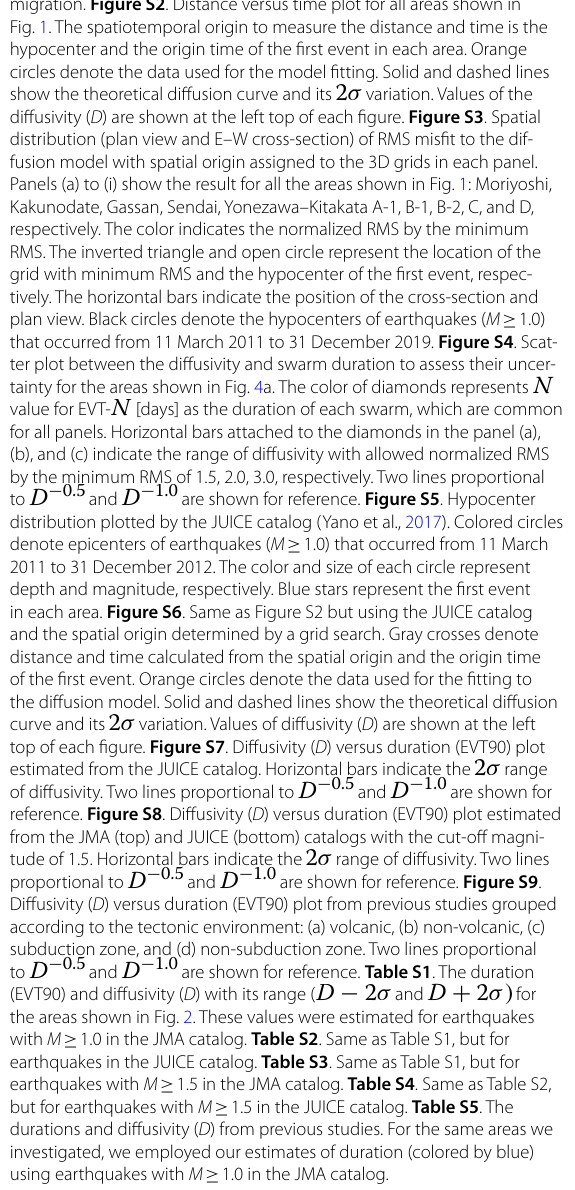
indicate no D value for Yonezawa–Kitakata A-2 because of no apparent migration. Figure S2 . Distance versus time plot for all areas shown in Fig. 1. The spatiotemporal origin to measure the distance and time is the hypocenter and the origin time of the first event in each area. Orange circles denote the data used for the model fitting. Solid and dashed lines show the theoretical diffusion curve and its 2 σ variation. Values of the diffusivity ( D ) are shown at the left top of each figure. Figure S3 . Spatial distribution (plan view and E–W cross-section) of RMS misfit to the dif- fusion model with spatial origin assigned to the 3D grids in each panel. Panels (a) to (i) show the result for all the areas shown in Fig. 1: Moriyoshi, Kakunodate, Gassan, Sendai, Yonezawa–Kitakata A-1, B-1, B-2, C, and D, respectively. The color indicates the normalized RMS by the minimum RMS. The inverted triangle and open circle represent the location of the grid with minimum RMS and the hypocenter of the first event, respec- tively. The horizontal bars indicate the position of the cross-section and plan view. Black circles denote the hypocenters of earthquakes ( M 1.0) ≥ that occurred from 11 March 2011 to 31 December 2019. Figure S4 . Scat- ter plot between the diffusivity and swarm duration to assess their uncer- N tainty for the areas shown in Fig. 4a. The color of diamonds represents N value for EVT- [days] as the duration of each swarm, which are common for all panels. Horizontal bars attached to the diamonds in the panel (a), (b), and (c) indicate the range of diffusivity with allowed normalized RMS by the minimum RMS of 1.5, 2.0, 3.0, respectively. Two lines proportional D − 0.5 D − 1.0 to and are shown for reference. Figure S5 . Hypocenter distribution plotted by the JUICE catalog (Yano et al., 2017). Colored circles denote epicenters of earthquakes ( M 1.0) that occurred from 11 March ≥ 2011 to 31 December 2012. The color and size of each circle represent depth and magnitude, respectively. Blue stars represent the first event in each area. Figure S6 . Same as Figure S2 but using the JUICE catalog and the spatial origin determined by a grid search. Gray crosses denote distance and time calculated from the spatial origin and the origin time of the first event. Orange circles denote the data used for the fitting to the diffusion model. Solid and dashed lines show the theoretical diffusion curve and its 2 σ variation. Values of diffusivity ( D ) are shown at the left top of each figure. Figure S7 . Diffusivity ( D ) versus duration (EVT90) plot estimated from the JUICE catalog. Horizontal bars indicate the 2 σ range D − 0.5 D − 1.0 of diffusivity. Two lines proportional to and are shown for reference. Figure S8 . Diffusivity ( D ) versus duration (EVT90) plot estimated from the JMA (top) and JUICE (bottom) catalogs with the cut-off magni- tude of 1.5. Horizontal bars indicate the 2 σ range of diffusivity. Two lines D − 0.5 D − 1.0 proportional to and are shown for reference. Figure S9 . Diffusivity ( D ) versus duration (EVT90) plot from previous studies grouped according to the tectonic environment: (a) volcanic, (b) non-volcanic, (c) subduction zone, and (d) non-subduction zone. Two lines proportional D − 0.5 D − 1.0 to and are shown for reference. Table S1 . The duration D + 2 σ) D − 2 σ (EVT90) and diffusivity ( D ) with its range ( and for the areas shown in Fig. 2. These values were estimated for earthquakes with M 1.0 in the JMA catalog. Table S2 . Same as Table S1, but for ≥ earthquakes in the JUICE catalog. Table S3 . Same as Table S1, but